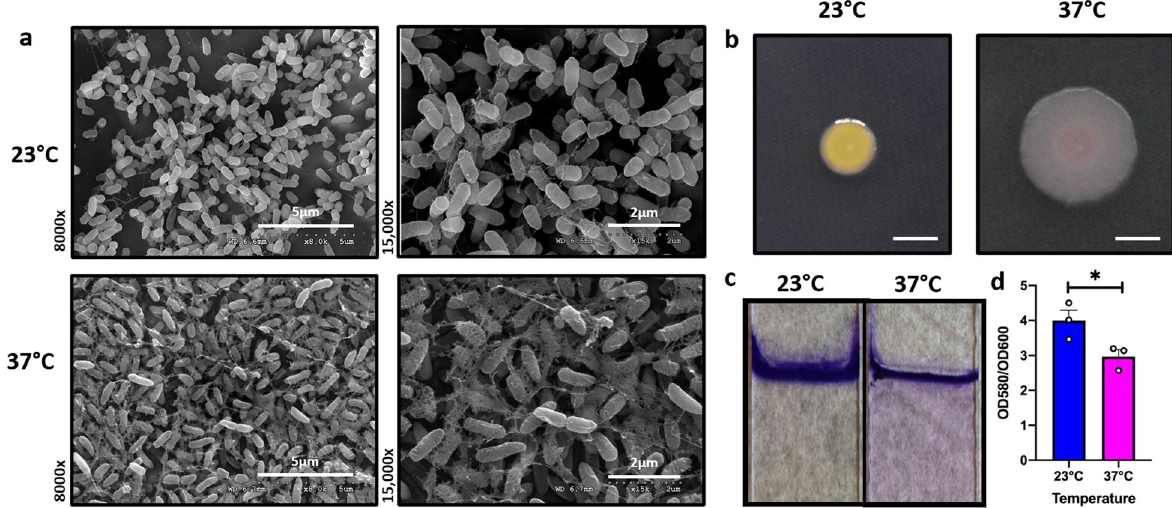
Fig. 1 Growth temperature in fl uences bio fi lm architecture in P. aeruginosa . a Comparison of the scanning electron microscopy images of Pseudomonas aeruginosa wild-type bio fi lms grown for 48 h at 23 and 37 °C. Images show ×8000 and ×15,000 magni fi cation and are representative of three independent experiments. b Congo red binding assay. Extracellular matrix production by the wild type was evaluated on tryptone agar plates containing Congo Red and Coomassie brilliant blue G after incubation at 23 and 37 °C for 72 h. Representative images of the colony morphologies of WT PA14 are shown. Scale bar: 5 mm. c Crystal violet staining revealed subtle temperature-dependent architectural differences. d The biomass of the bio fi lm was higher at 23 °C when compared to 37 °C. Bars represent the mean of three biological replicates performed on different days. The mean of each biological replicate was based on three technical replicates. Error bars represent the standard error of mean of the biological replicates. Unpaired t -test (two-tailed) was used to measure statistical signi fi cance. * p =